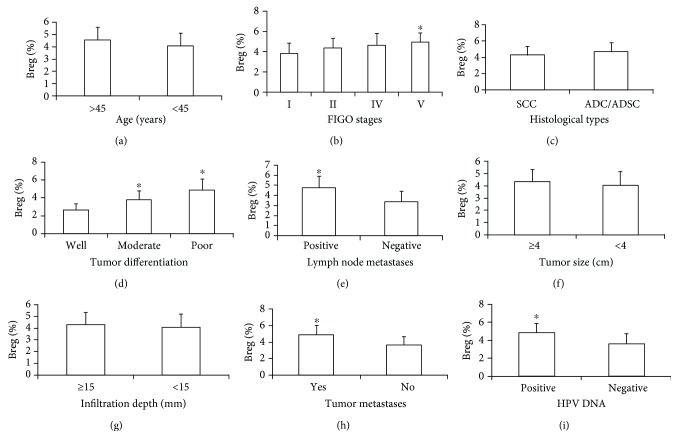
The relationship between Breg cells and clinical features of cervical cancer. The relationship between Breg cell ratios of cervical cancer patients and (a) age, (b) FIGO stages, (c) histological types, (d) tumor differentiation, (e) lymph node metastasis, (f) tumor diameter, (g) invasion depth, (h) tumor metastasis, and (i) HPV DNA was analyzed. ∗P < 0.05 means statistically significant.